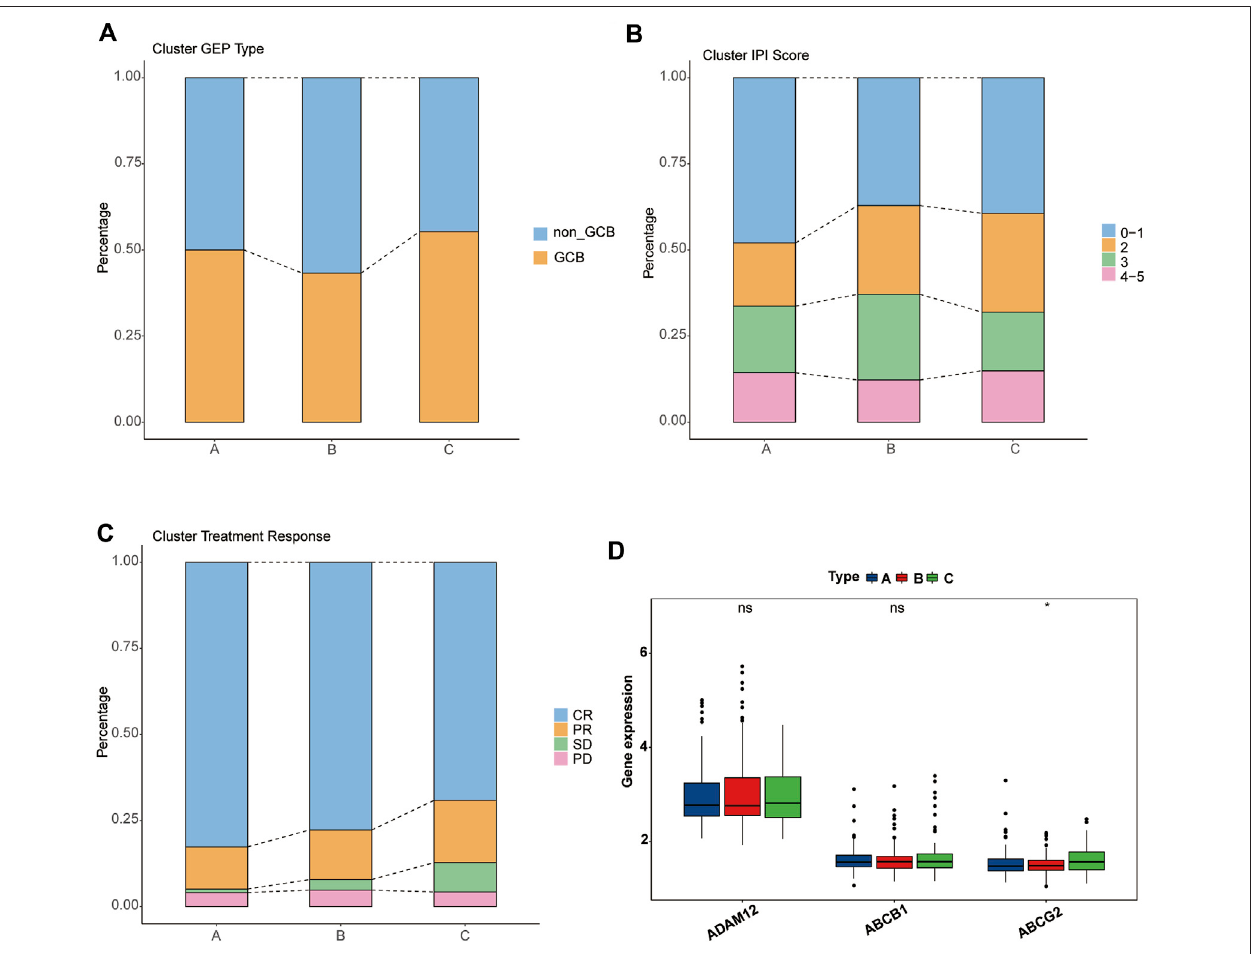
FIGURE 4 | Clinical characteristics of pyroptosis-related clusters. (A – C) Differences in the proportion of GEP phenotypes, IPI score, and RCHOP regimen responsesamongthethreeclusters.Differentcolorsrepresentdifferentsubtypes, andthecolumn heightcorresponds totheproportion. (A) GEPtype. (B) IPI score. (C) RCHOP regimen response. (D) Comparison of the drug-resistance gene expression among clusters A, B, and C.